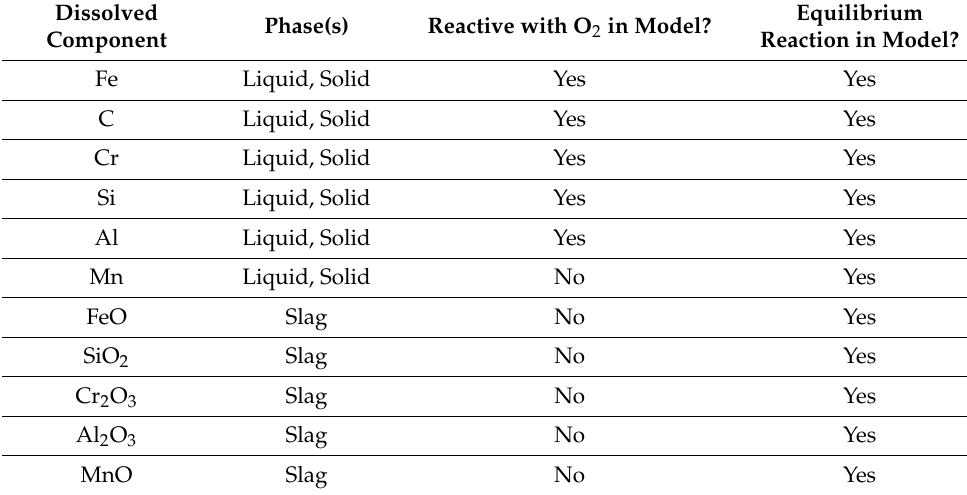
, T water and T offgas can be compared to roof vessel Equilibrium Reaction in